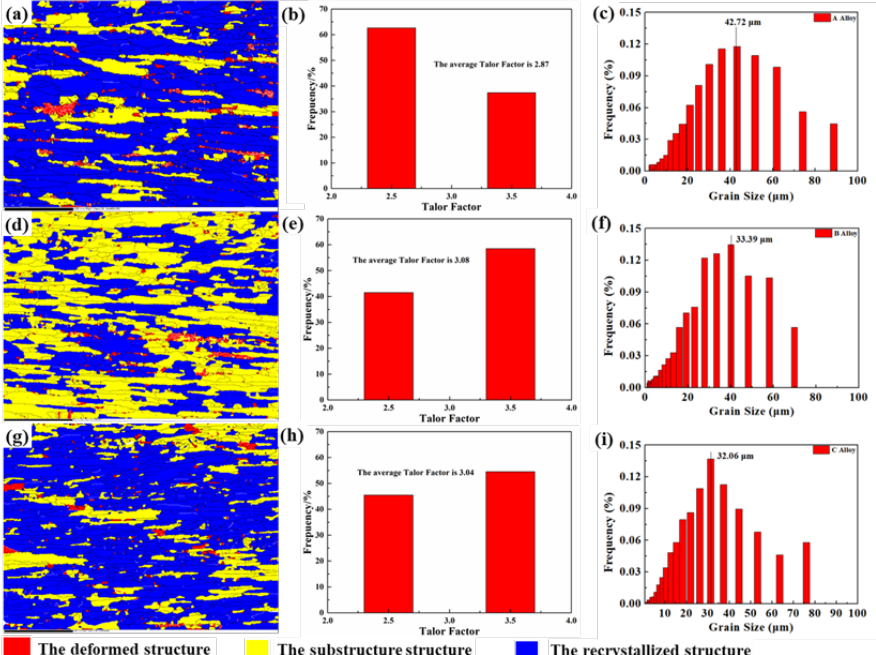
Figure 4. EBSD maps of Al-5Zn-2.6Mg-xCu alloys: ( a ) x = 0.24 wt.%, ( d ) x = 0.43 wt.%, and ( g ) x = 0.91 wt.% and corresponding frequency distribution of ( b , e , h ) Taylor factor and ( c , f , i ) grain size.